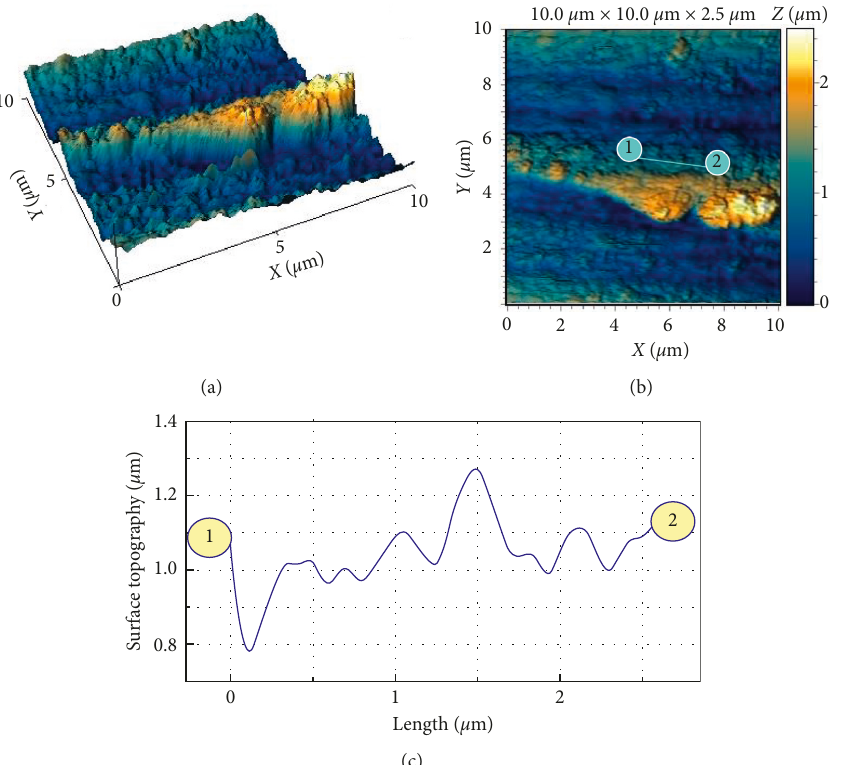
Figure 9: 3D (a) and 2D maps (b) of the surface and cross-sectional profile between markers 1 and 2 (c) for coating Ti │ TiO area AFM 10 10 μ m. Content of Zr 2.1% by weight. ×